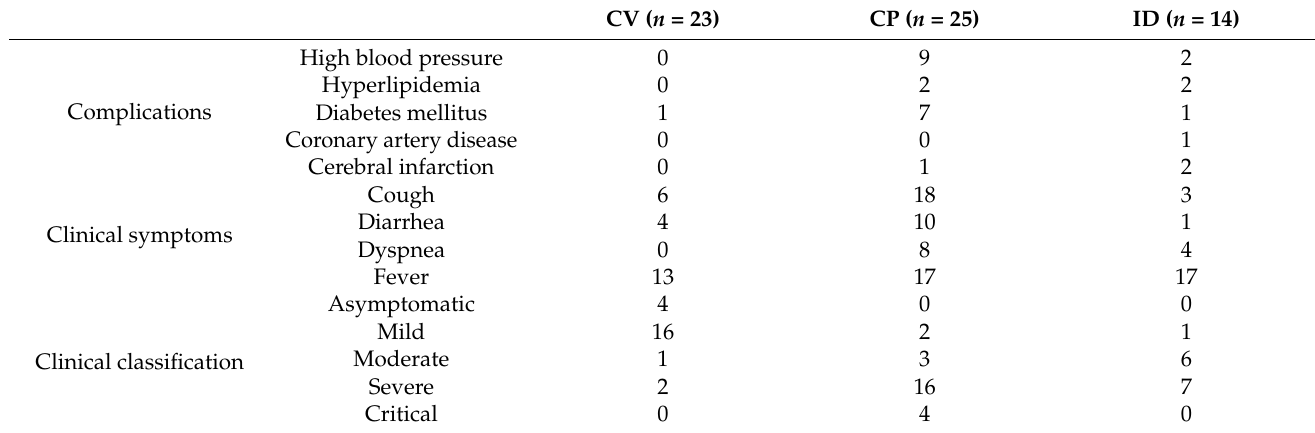
Table 2. Clinical characteristics of patients in this